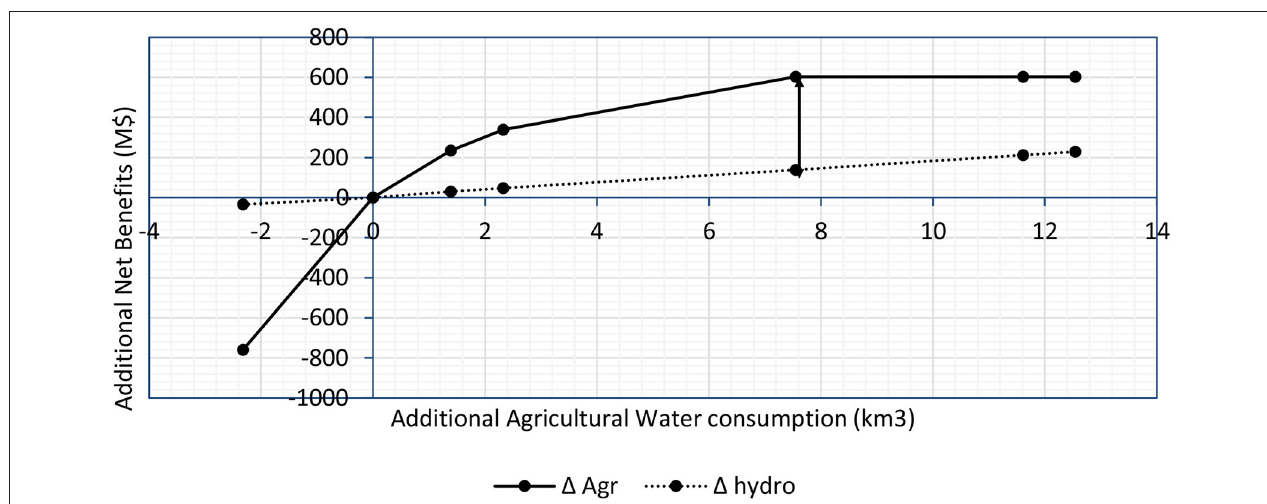
Frontiers in Environmental Science |